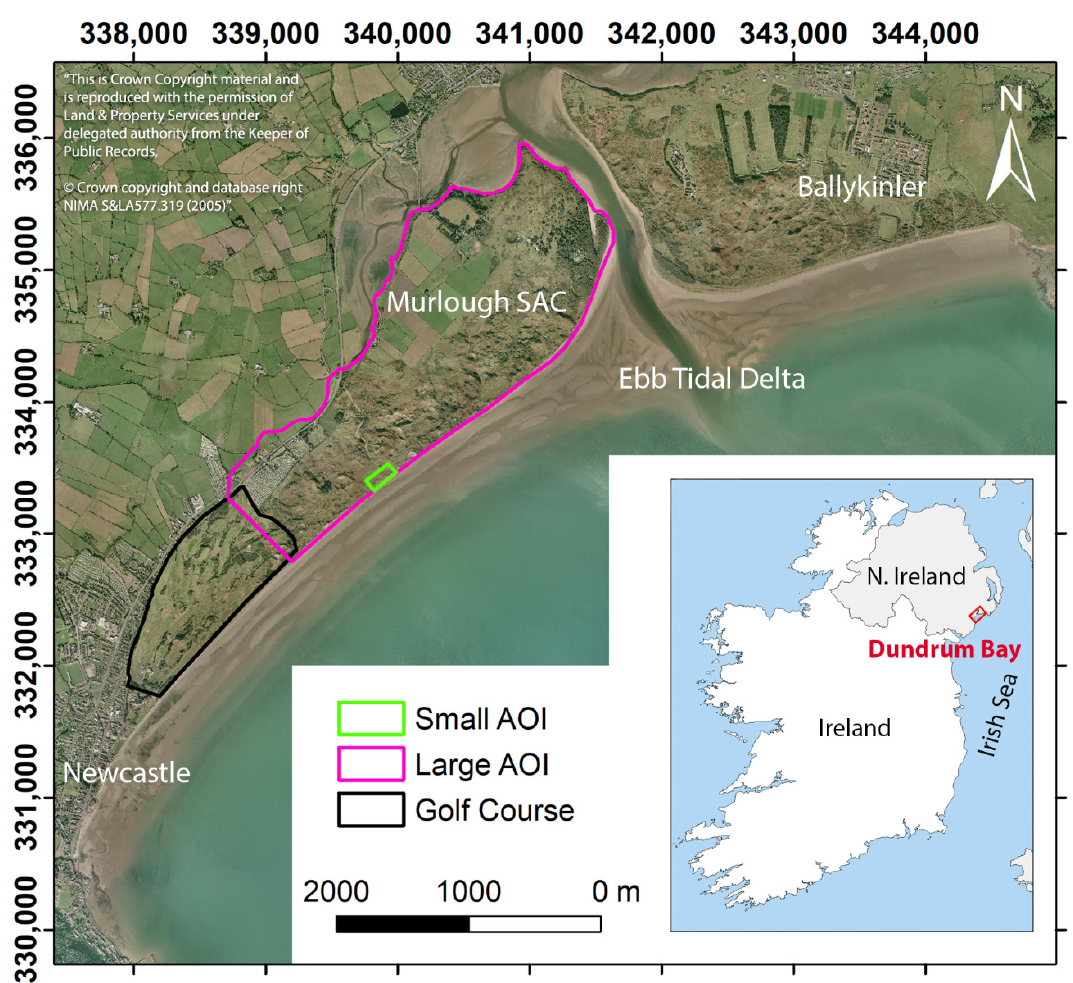
Figure 1. Location of the study area with indications of the two areas of interest (AOIs). The background 2005 orthophoto was provided by the Ordnance Survey of Northern Ireland (OSNI). The graticule is in the TM75/Irish Grid (transverse mercator) projection. SAC stands for Special Area of Conservation.